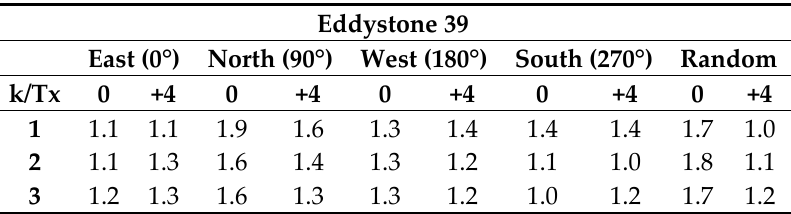
Table 2. Accuracy (m) for Eddystone protocol, channel 39 and Euclidean distance for two values of transmission power: Tx = 0 dBm and Tx = +4 dBm.